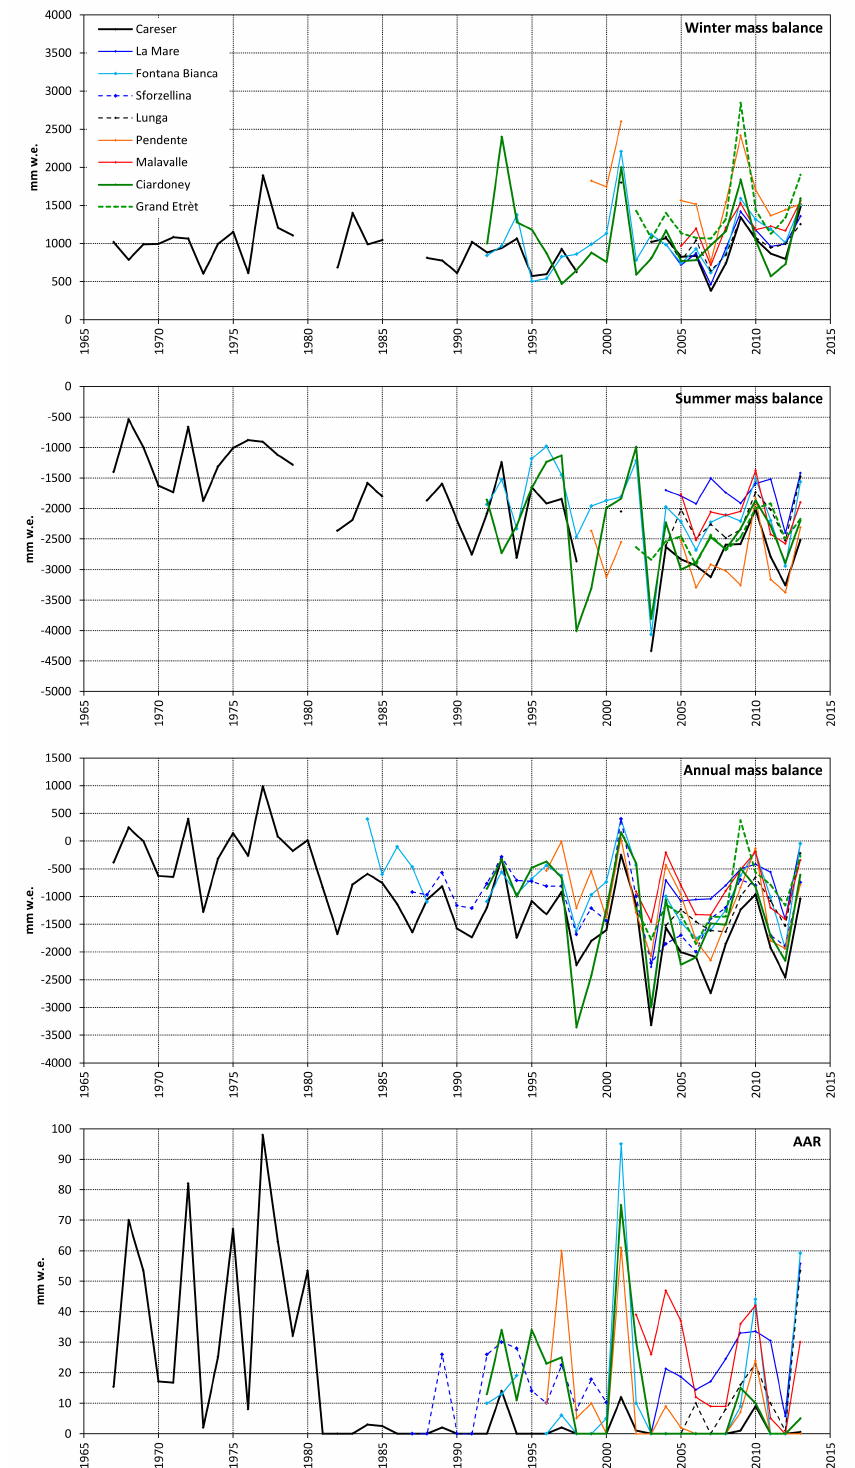
Figure 3. Time series of B w , B s , B a and AAR for the nine Italian glaciers analyzed.